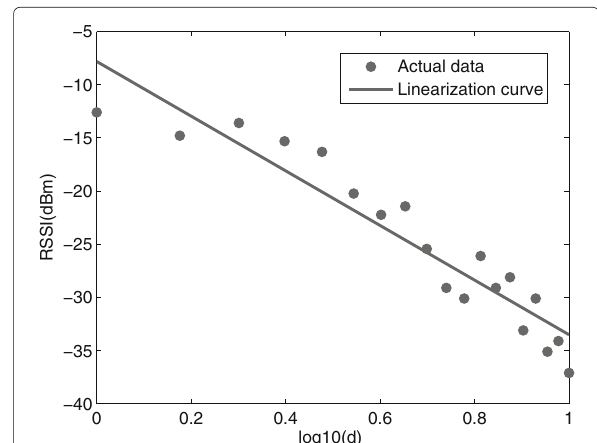
Fig. 4 Relationship of measured RSSI values and distance